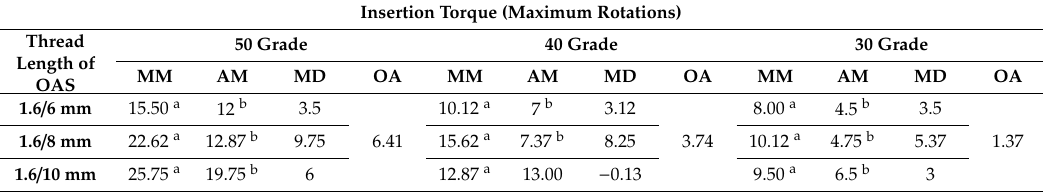
Table 6. Comparison of insertion torque values (maximum rotations) between the automatic device and manual anchorage